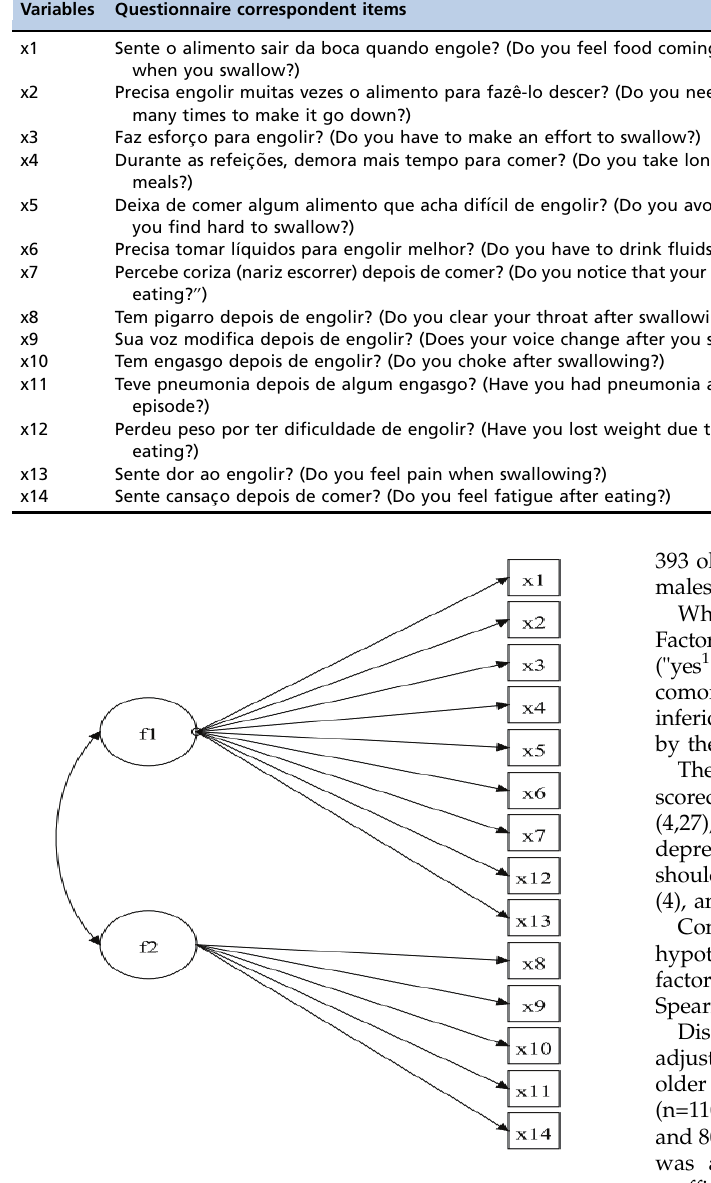
Figure 1 - The hypothetical, theoretical framework screening model. This unidimensional measurement model was defined with 14 observable variables: x1: Oral regurgitation; x2: Multiple swallows; x3: Swallowing with effort; x4: Longer time to eat; x5: Limit food intake; x6: liquids with meals; x7: Nasal regurgitation; x8: Throat clearing; x9: Wet voice; x10: Choking; x11: Recurrent pneumonia; x12: Weight lost; x13: Painful swallowing; and x14: Fatigability. These variables are grouped into two factors (latent variables): f1: non-efficiency swallowing; f2: unsafe